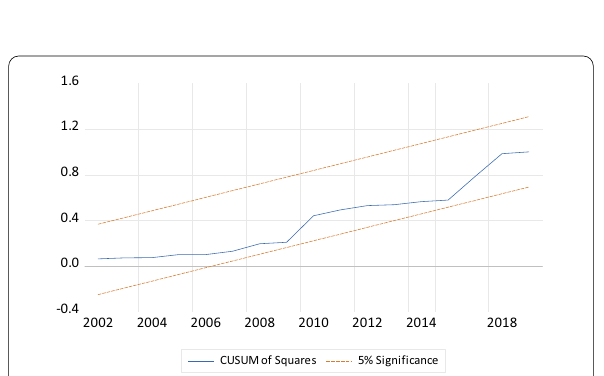
Fig. 5 Plot of cumulative sum of squares of recursive residuals. Source Generated by the author using Microfit 4.1